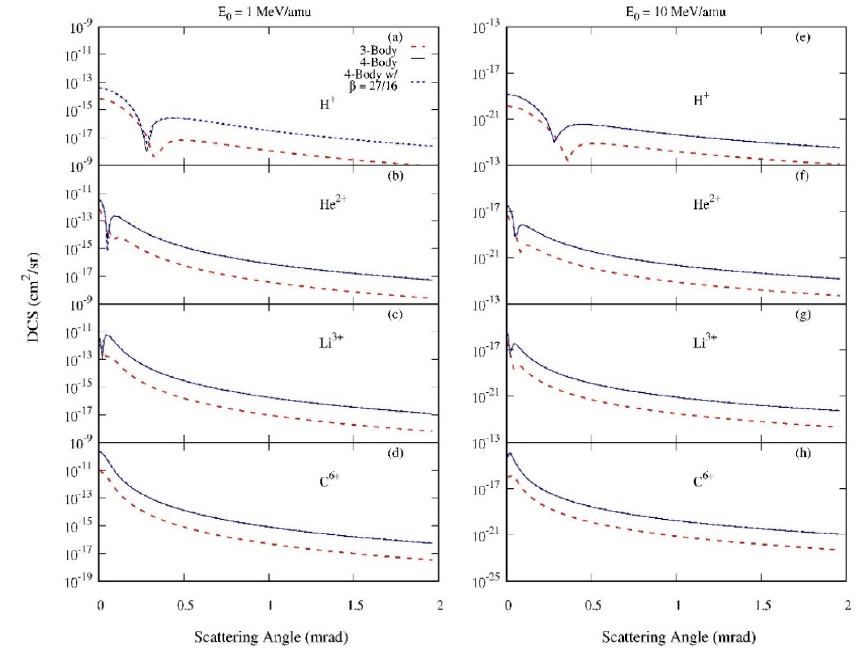
Figure 2. Same as Figure 1, with DCS calculated using the four-body model with the uncorrelated wave function and the three-body model with the hydrogenic wave function. A calculation using the four-body model (uncorrelated) with β = 27/16 is also shown.